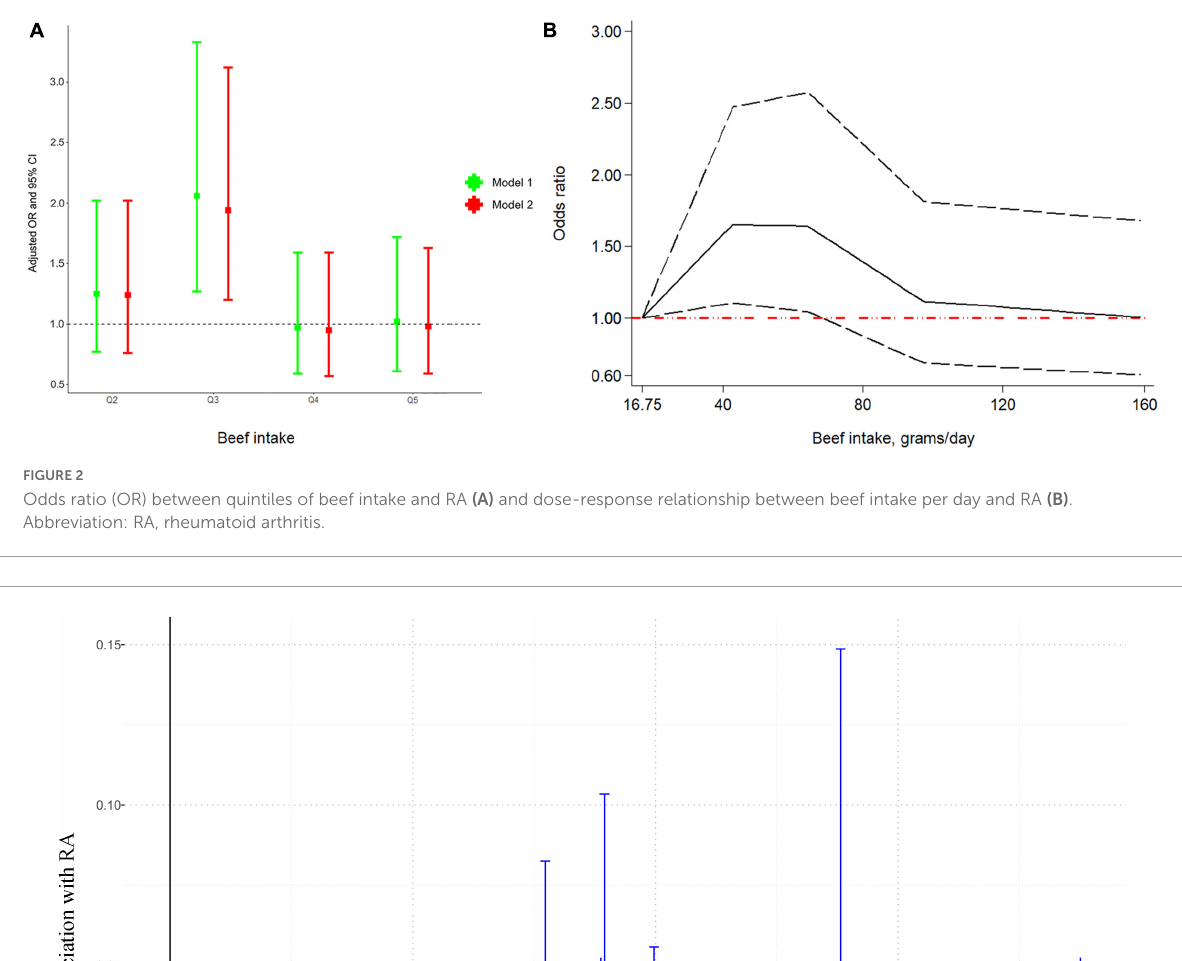
study. Compared with non-RA individuals, patients with RA seemed to have higher BMI and lower poverty-income